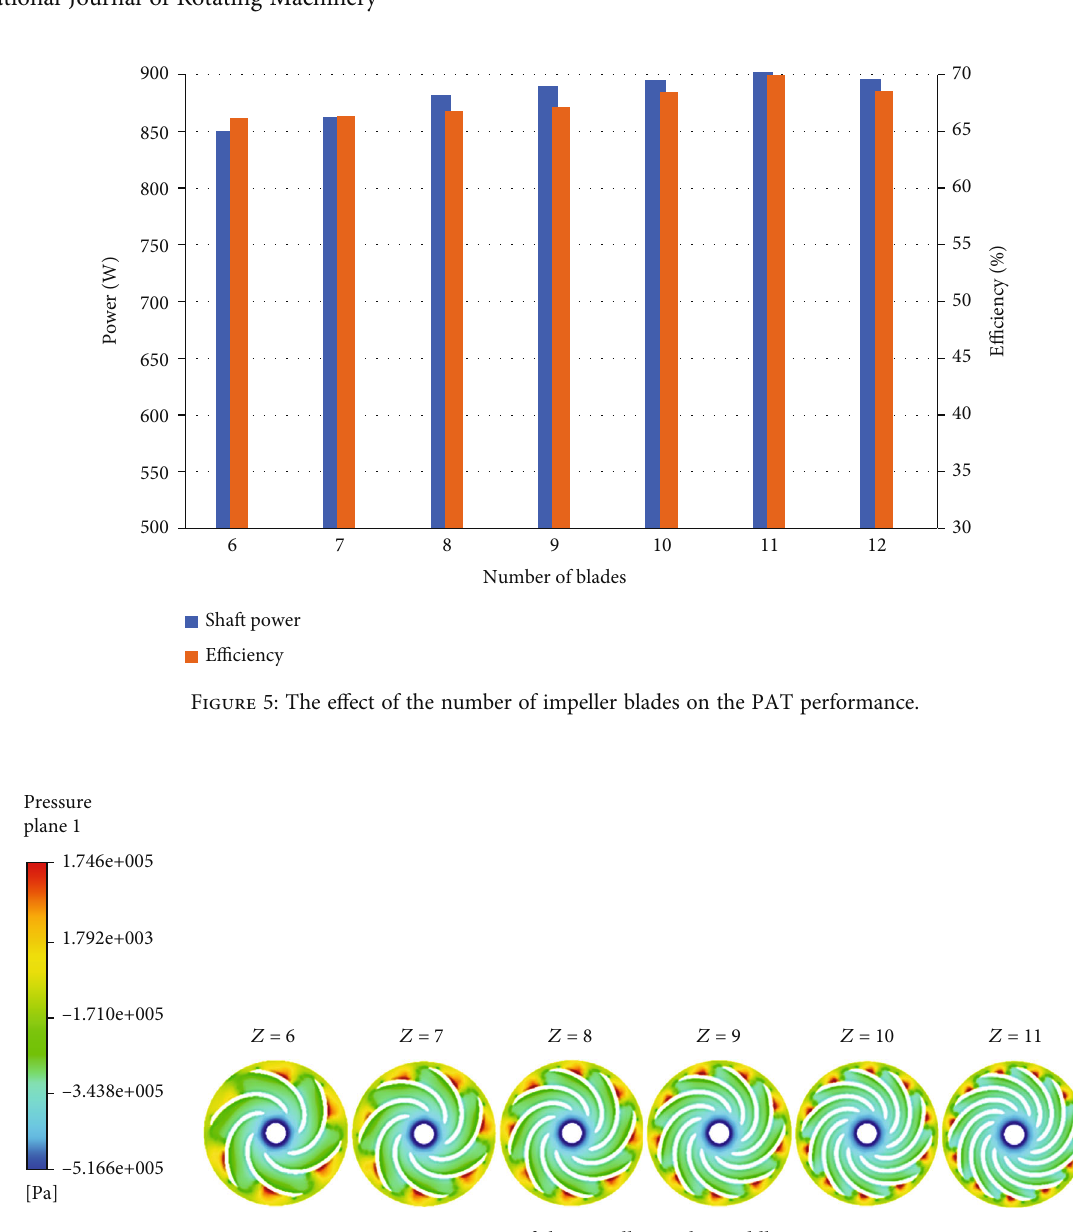
Figure 6: Pressure counters of the impeller in the middle